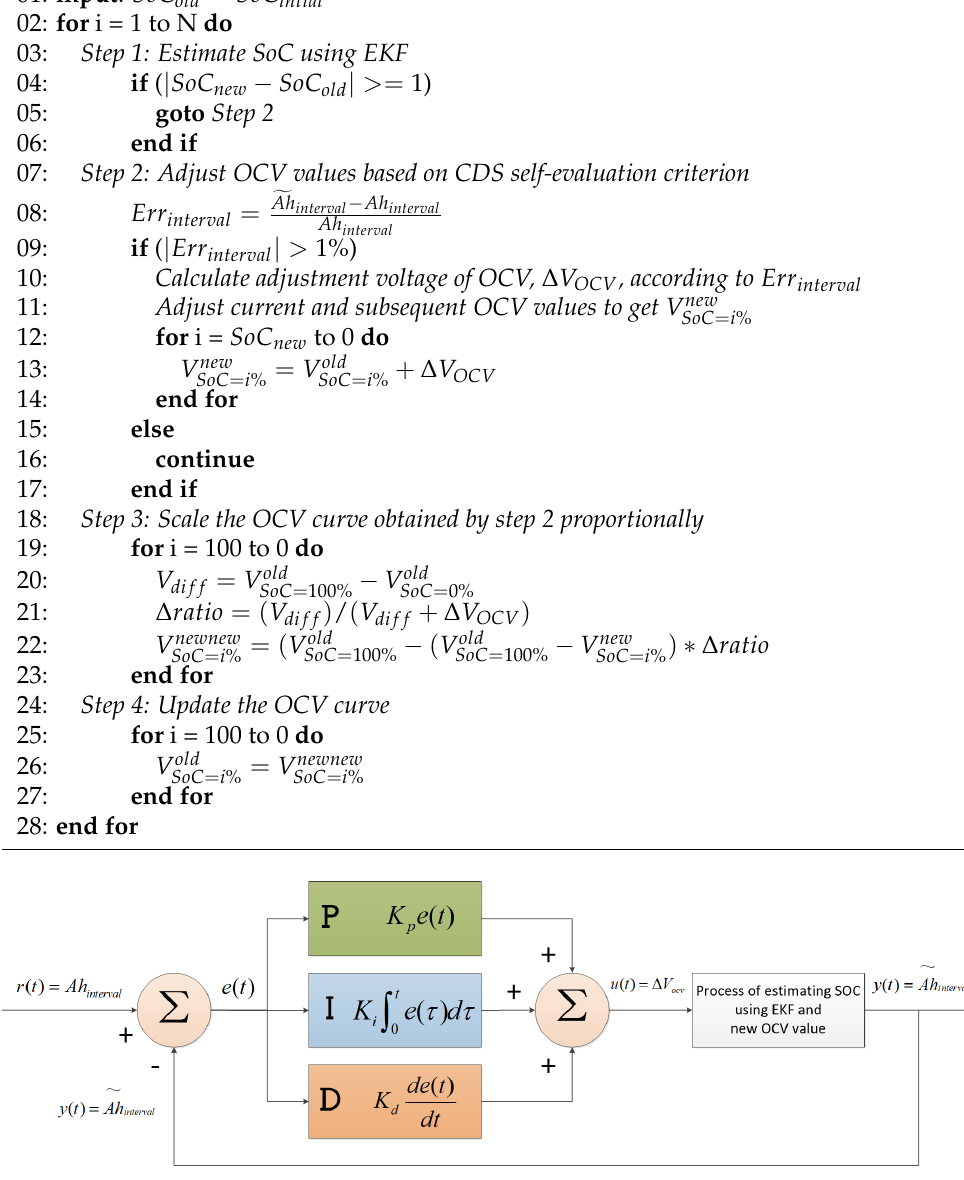
Figure 6. PID controller for adjustment of ∆ V OCV